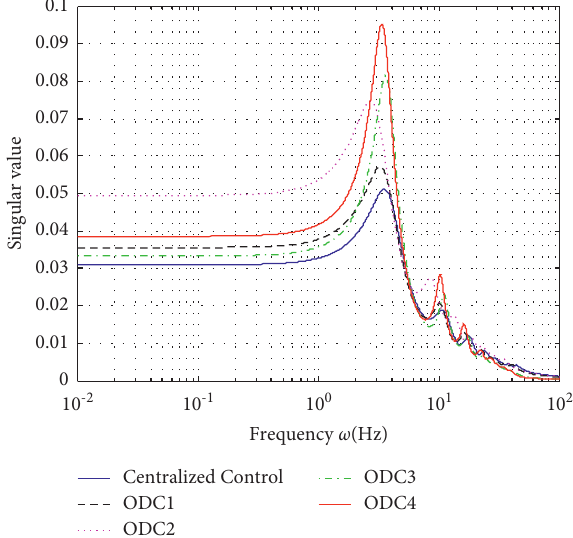
Figure 6: The maximum singular values of time delay τ �